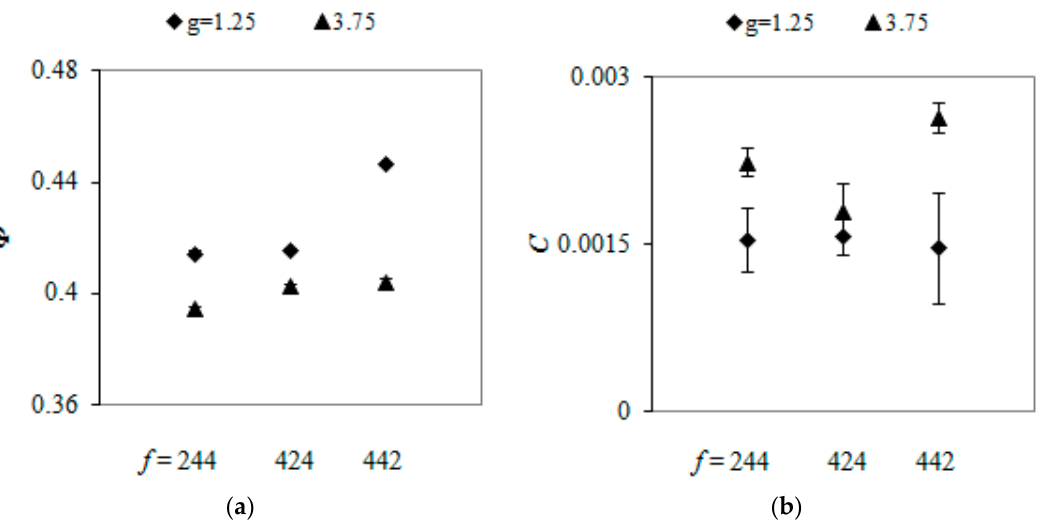
Figure 11. Evolution of porosity ( a ) and compression index ( b ) with number fraction of particles with different sizes in mixtures with g = 1.25 and g = 3.75.